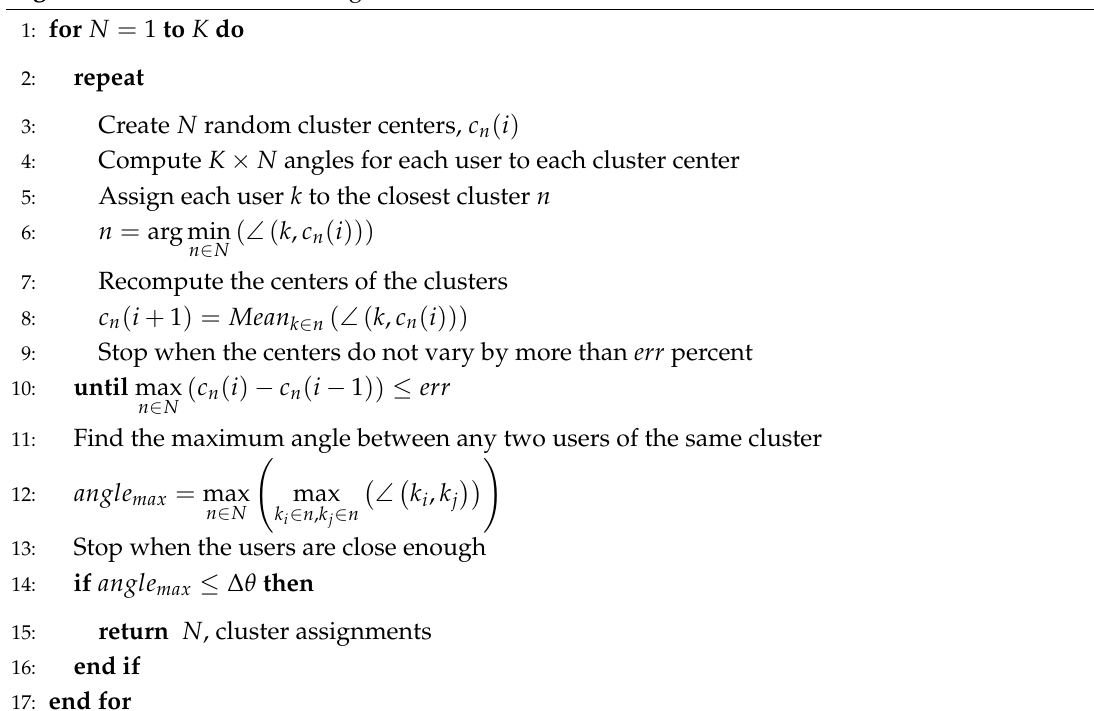
Algorithm 1 K-means